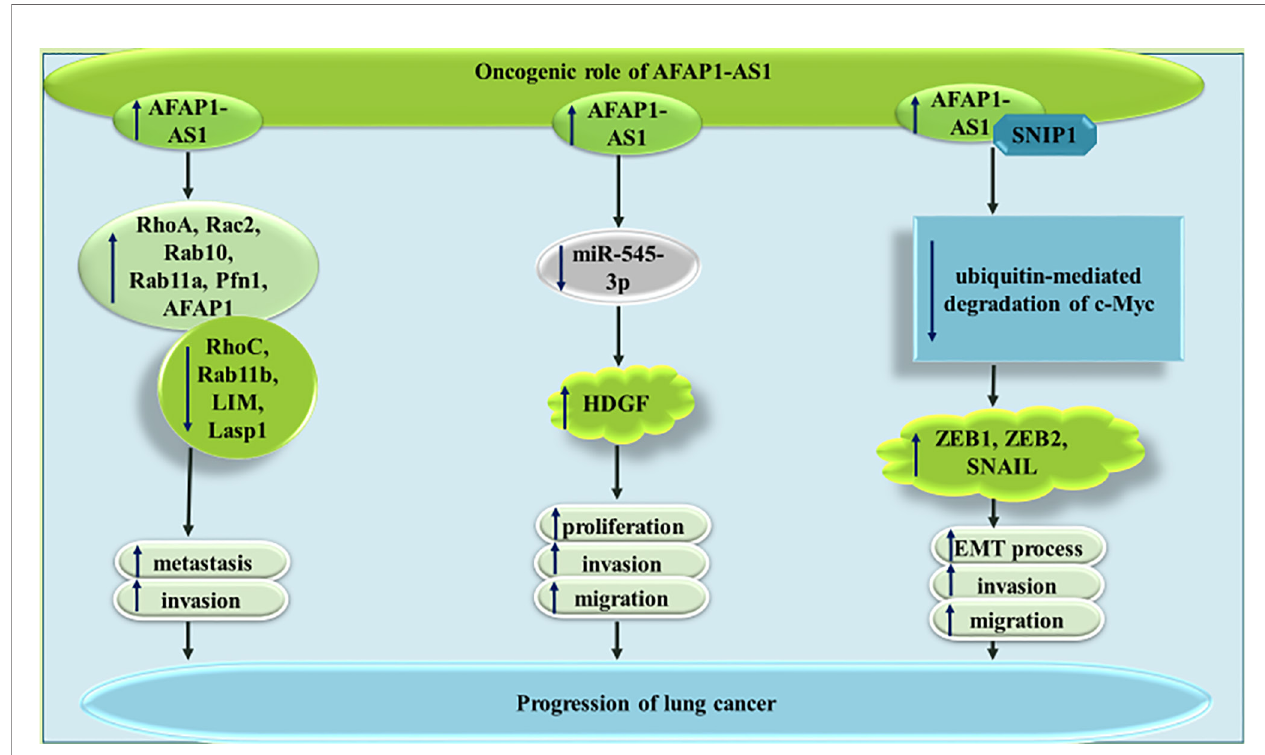
FIGURE 2 | The oncogenic role of AFAP1-AS1 in lung cancer